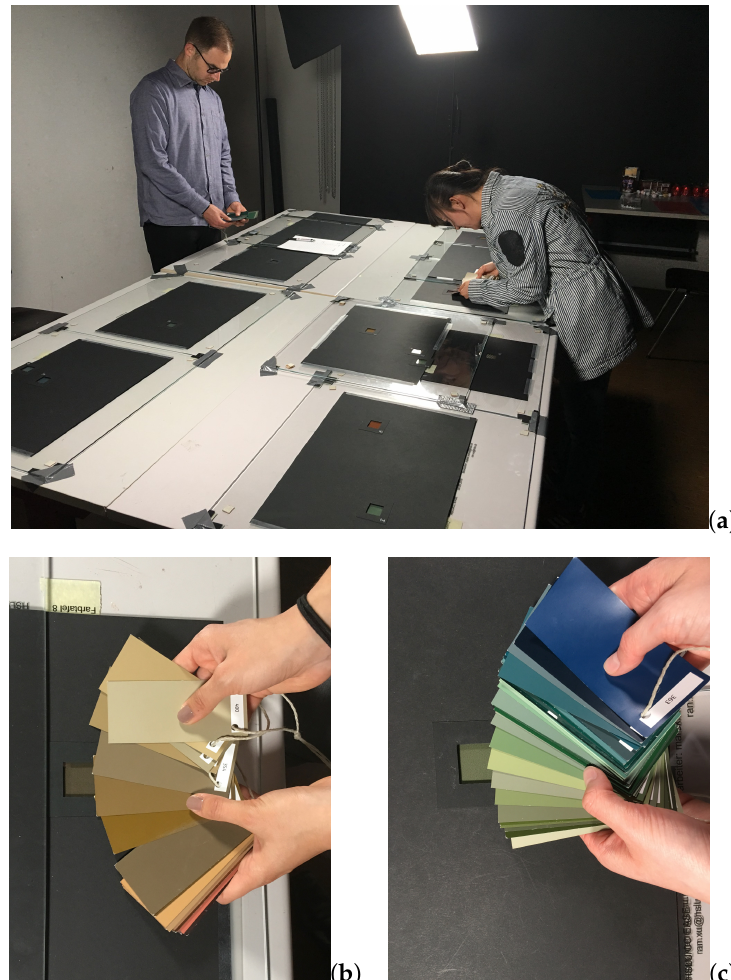
Figure 7. Setup for our visual matching experiment to verify the computed matches ( a ). The lighting conditions were identical to those for the image capture shown in Figure 3. Volunteer observers were asked to match each of 16 printed glass colours to one or two NCS exterior set colour cards. The colours were equally divided into red-brown ( b ) and green-blue ( c ) hues. The appearance of PV modules behind the glass panels was approximated with grey